Question: What style of plot is this figure drawn as?
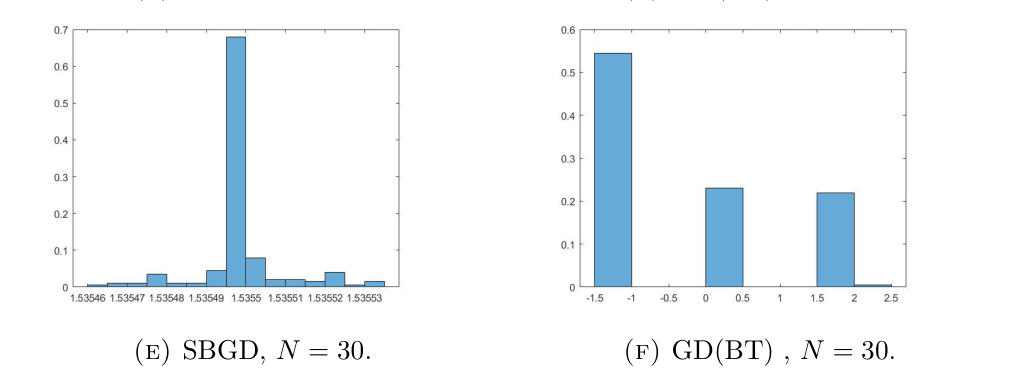
Answer: histogram